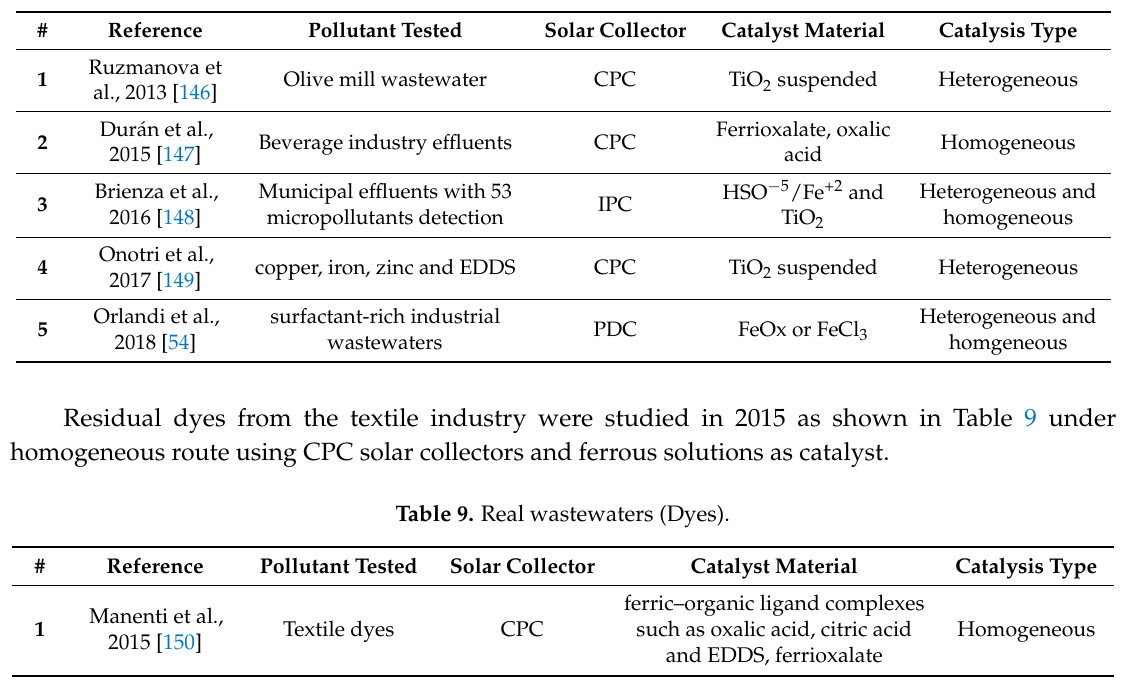
Table 8. Real wastewaters (Industrial general chemical products).